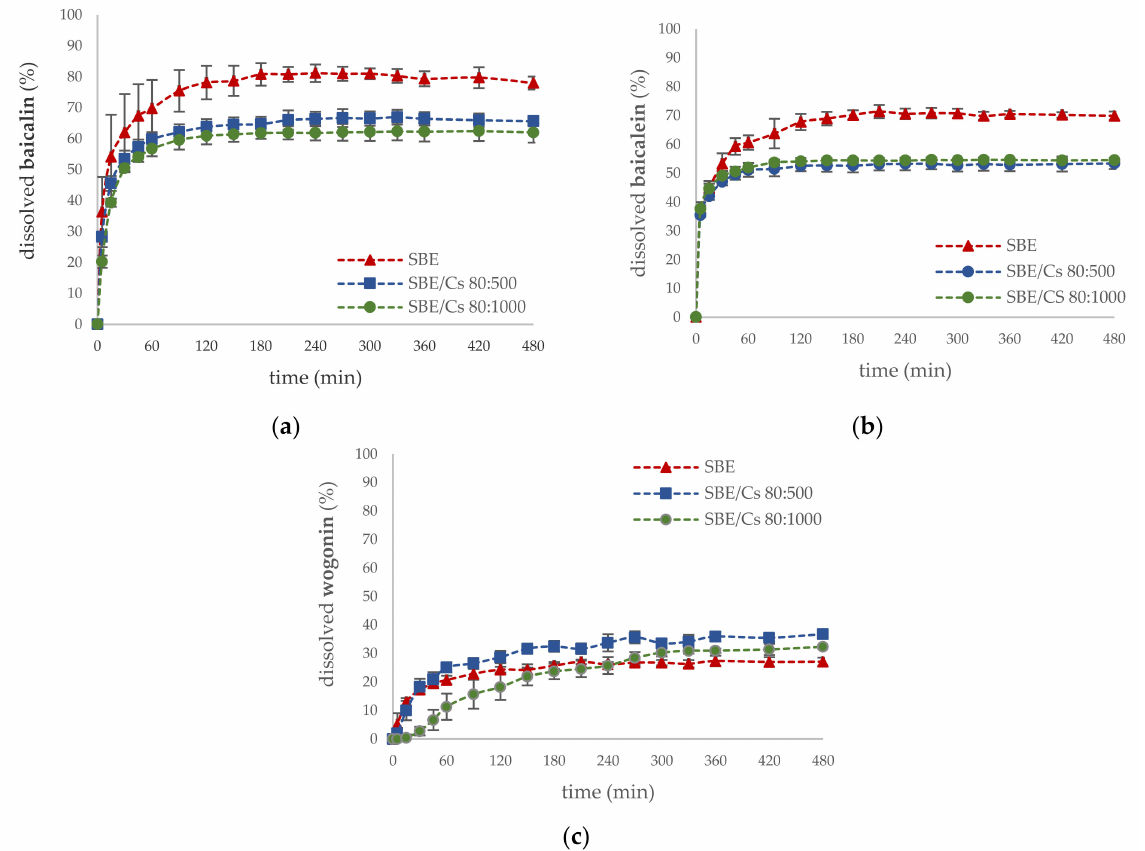
Figure 3. Dissolution profiles of ( a ) baicalin; ( b ) baicalein; ( c ) wogonin of S. baicalensis radix extract and binary mixtures in pH